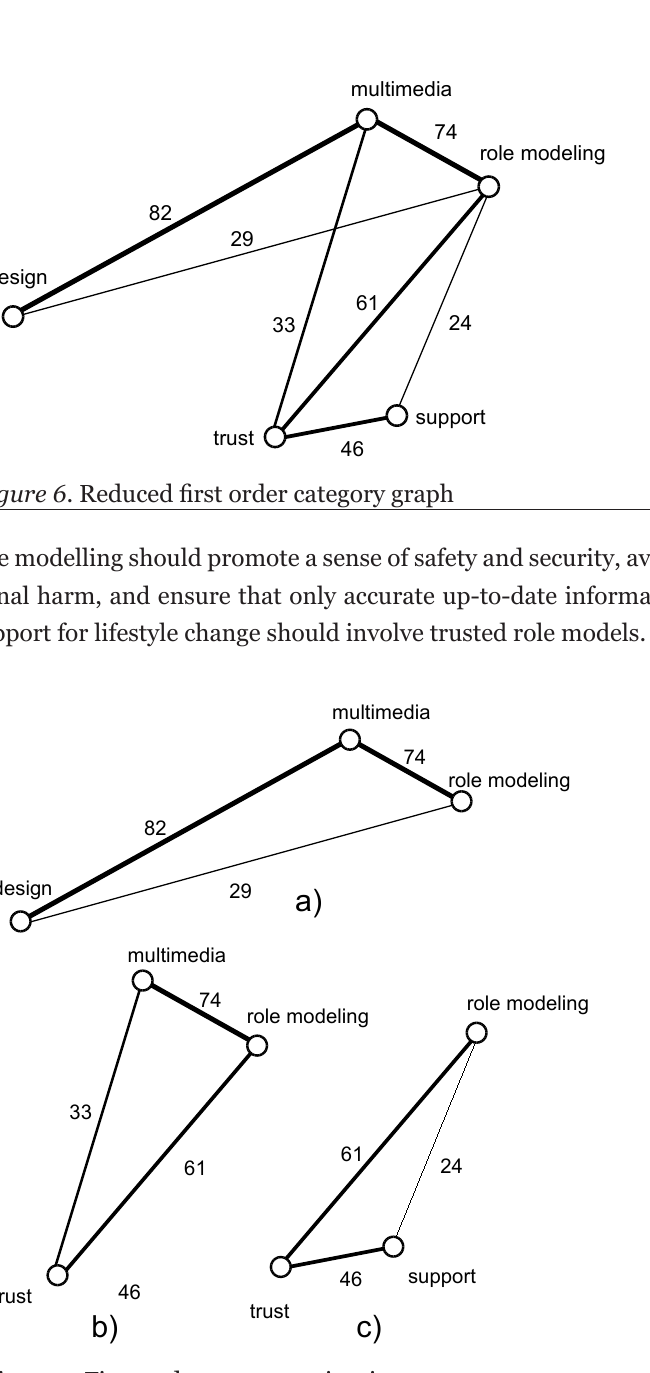
Figure 7. First-order category